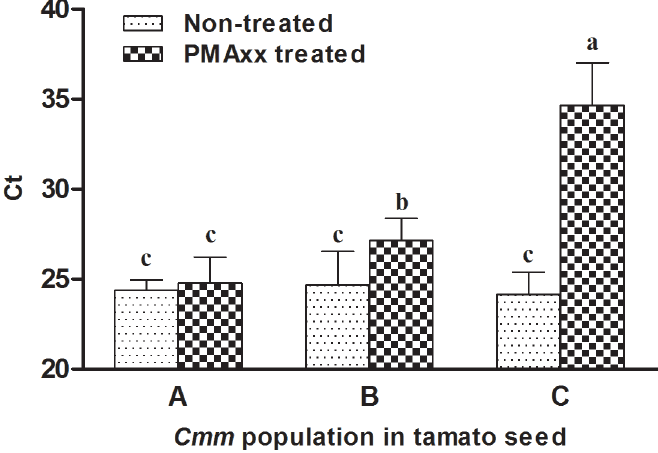
Fig 4. Detection of culturable, viable but non-culturable (VBNC) and dead cells of Clavibacter michiganensis subsp. michiganensis ( Cmm ) by PMAxx-qPCR from artificially inoculated tomato seed. Ten tomato seeds were soaked in log phase (A), copper-induced VBNC (B) and heat-killed (C) Cmm cells suspension (10 8 CFU mL -1 ) by vacuum infiltration. After inoculation, the seed was broken by a ball mill and diluted 20-fold with 0.85% NaCl solution, followed by treatment with or without PMAxx at a final concentration of 20 μ M. DNA was extracted after PMAxx treatment and used for qPCR assay. Cycle threshold (Ct) of qPCR was separated using multiple range test, and means labeled with different letters were significantly different ( P <